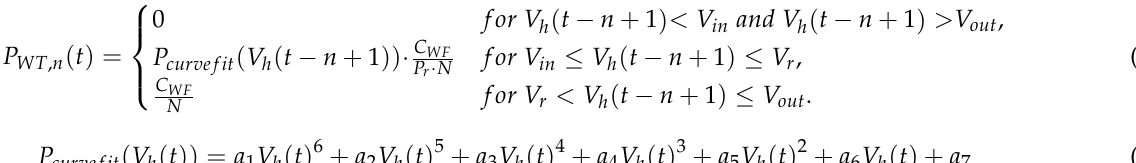
Table 1. Parameters of wind turbines (onshore and offshore). Onshore Offshore Rated power 3 MW 8 MW Cut-in wind speed 3 m/s 3.5 m/s Rated wind speed 10 m/s 10 m/s Cut-out wind speed 20 m/s 25 m/s Tower hub height 120 m 130